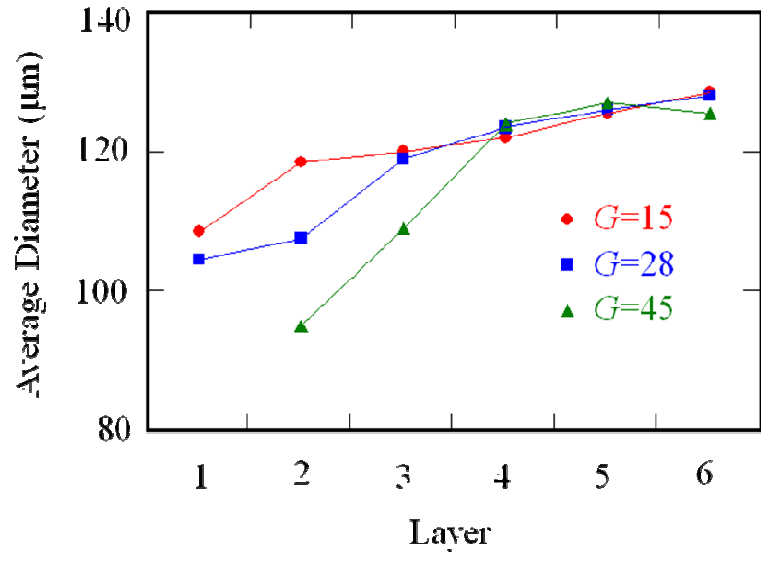
Figure 1. The average particle size of plaster/corundum model FGM fabricated by the centrifugal solid-particle method